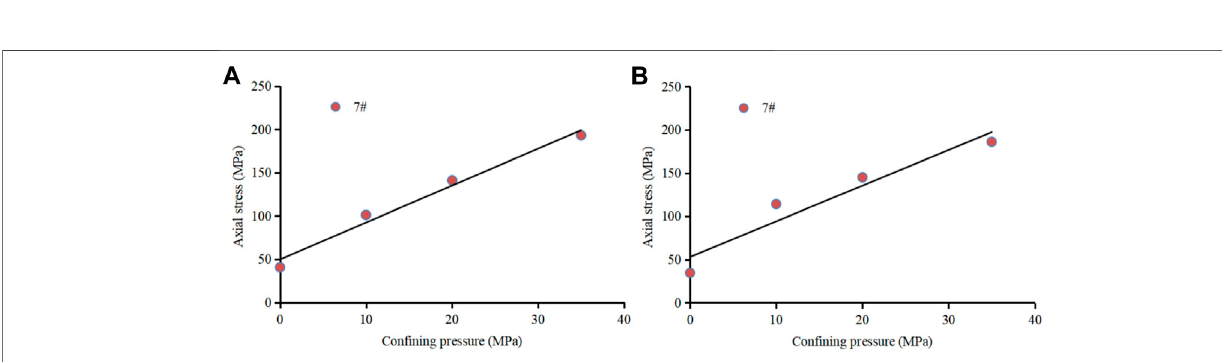
Frontiers in Earth Science |